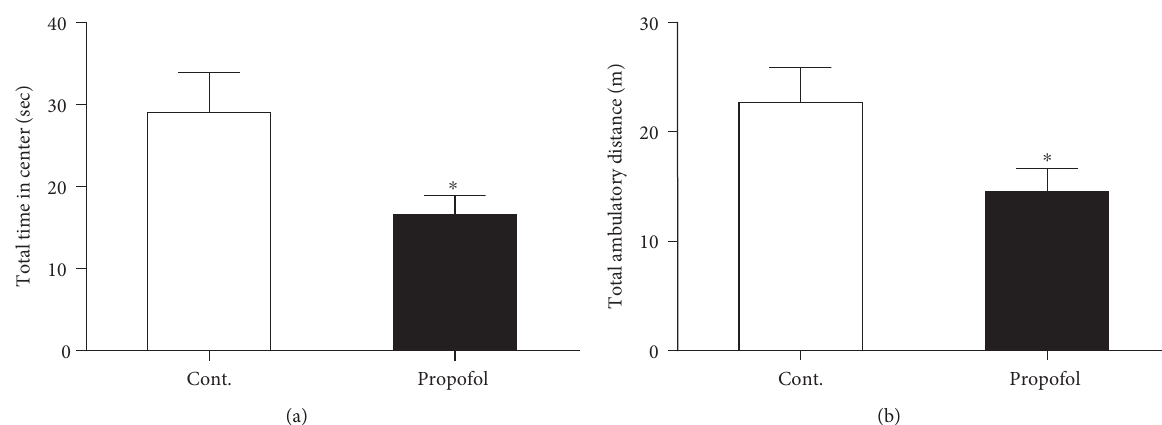
Figure 3: Propofol caused anxiety-like behaviours of mice in the open fi eld test. (a) Propofol decreased the total time in the center area of mice compared to control mice in the open fi eld test. (b) Propofol decreased the total travel distance of mice compared to control mice in the open fi eld test. All data are expressed as the means ± SEM . n = 10 . ∗ p < 0 05 .